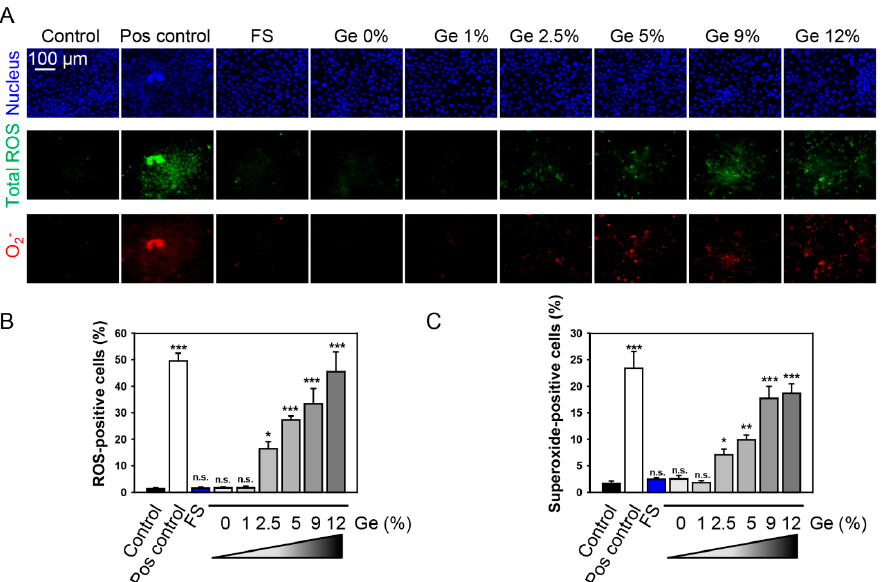
Figure 6. Cell growth on different Ge substrates results in reactive oxygen species (ROS) accumulation. ( A ) Cells were cultured on different Ge substrates for 5 days. Cells were labeled with the ROS-sensitive fluorescent dyes using the cellular ROS/superoxide detection kit (Abcam, Cambridge, United Kingdom). Total ROS were labeled with green dye and superoxide anion with red dye. The nuclei were counterstained with Hoechst blue. Cells were imaged using epifluorescent microscope IM-2FL (OPTIKA Italy). Cells treated with H 2 O 2 (1 mM for 30 min) were used as a ROS positive control. Representative images out of three independent experiments are shown. ( B ) Quantitative analysis of total ROS-positive cells cultured on different Ge substrates for 5 days. ImageJ software (NIH) was used for image processing and quantification. One-way ANOVA with Newman–Keuls multiple comparison test was used. Data are expressed as means ± SEM (n = 3), * p < 0.05 ** p < 0.01 *** p < 0.001. ( C ) Quantitative analysis of total superoxide-positive cells cultured on different Ge substrates for 5 days. ImageJ software (NIH) was used for image processing and quantification. One-way ANOVA with Newman–Keuls multiple comparison test was used. Data are expressed as means ± SEM (n = 3), * p < 0.05 ** p < 0.01 *** p < 0.001.